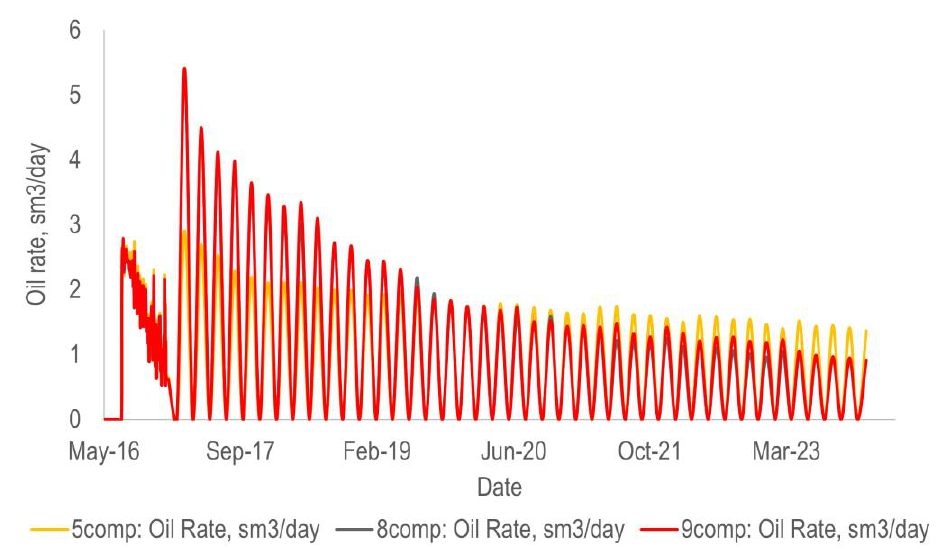
Figure 9. Oil rate for five-, eight-, and nine-component models.